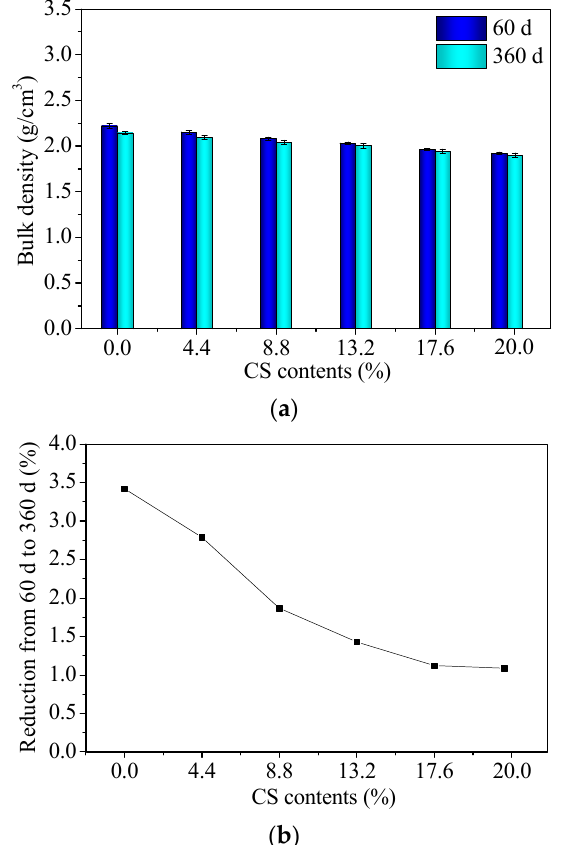
Figure 5. ( a ) Bulk densities and ( b ) reduction percentage of CS–FA–GEO composites with different CS contents.